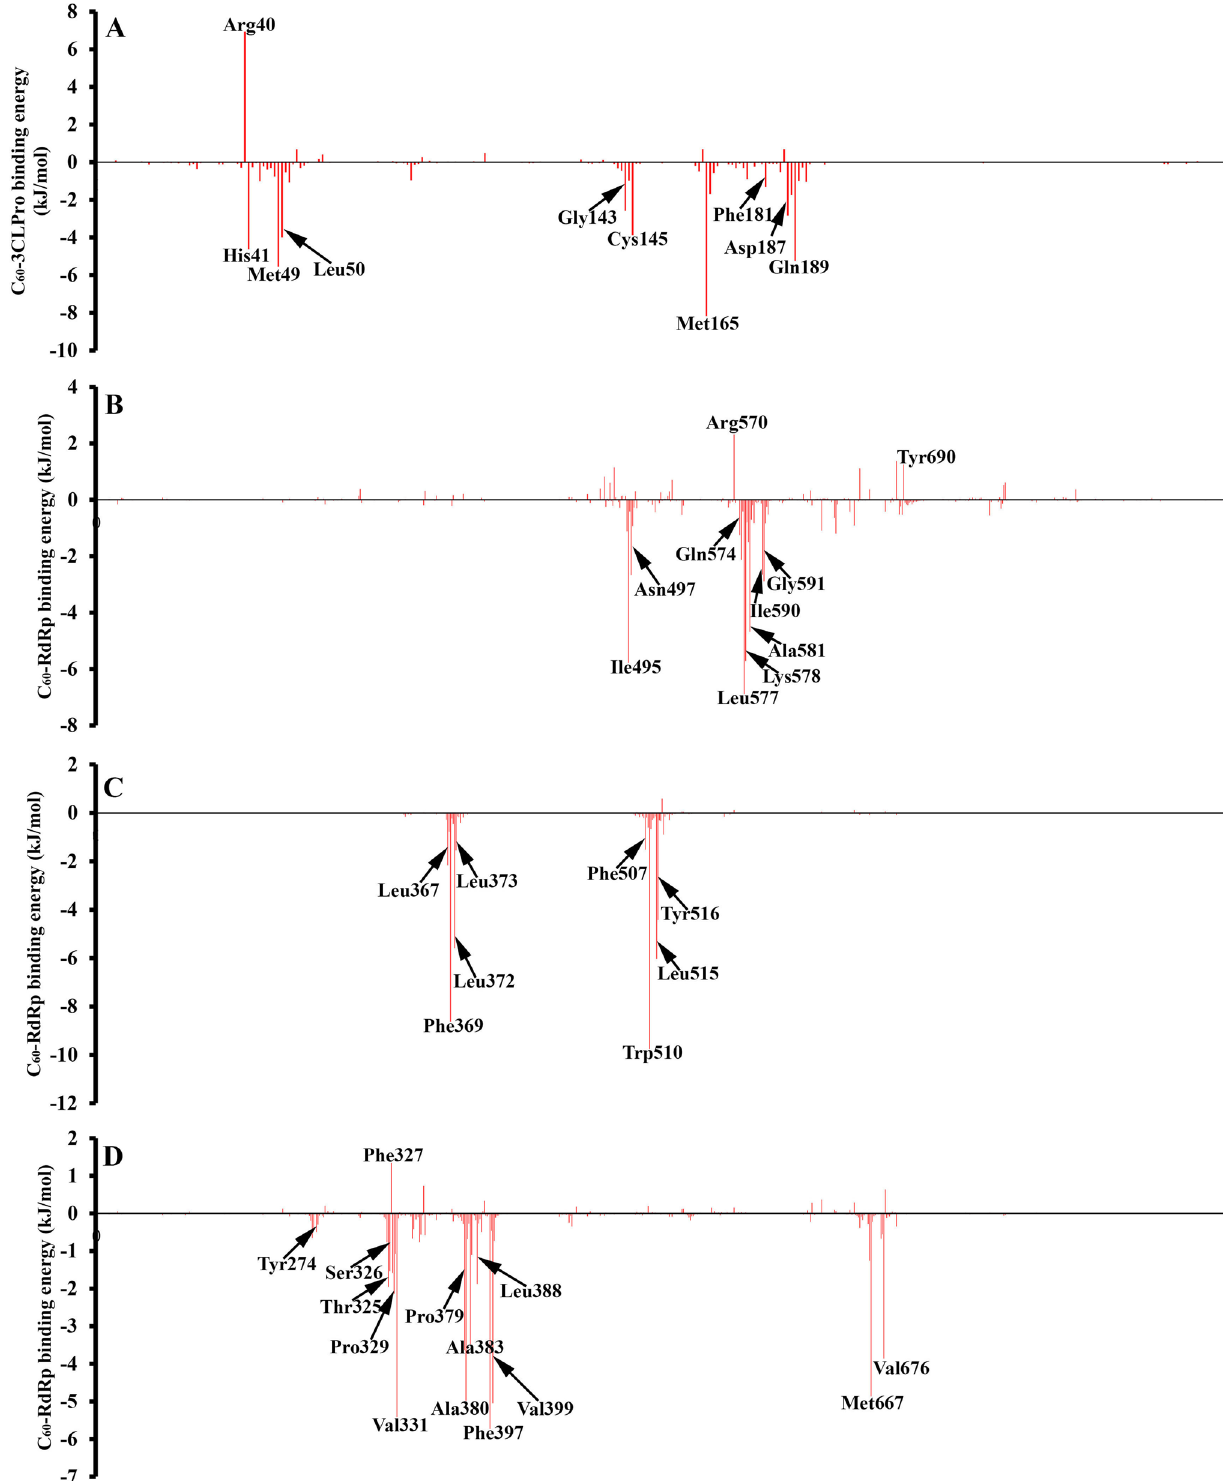
Figure 7. Per-residue binding energy decomposition of investigated complexes: “C 60 fullerene-3CLpro” ( A );